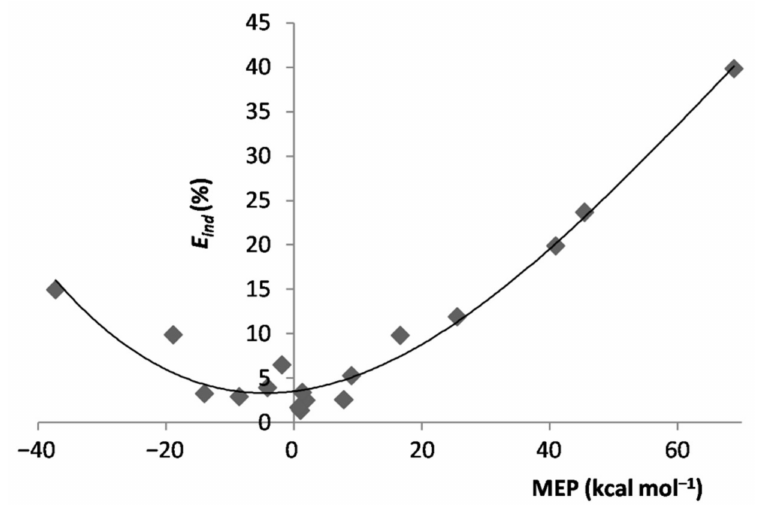
Figure 4. E ind ( % ) of the LAr vs. MEP at the V S,max /V S,min of